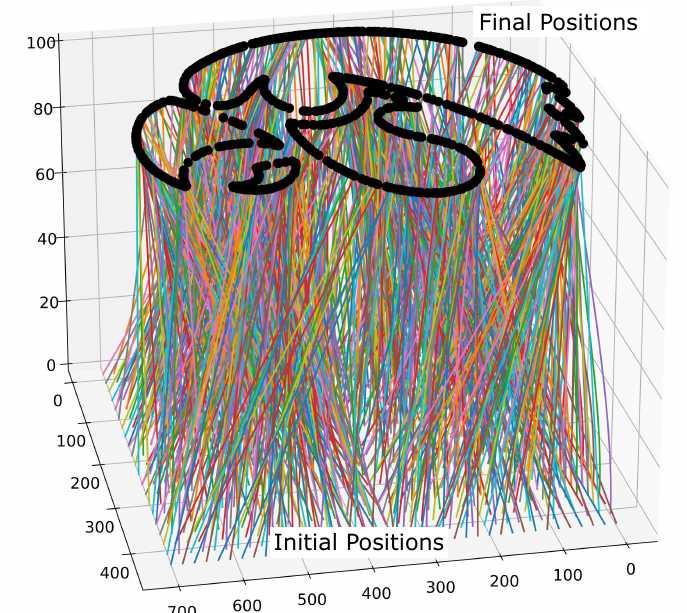
Figure 36. Trajectories for 1000 aerial vehicles with initial and final position and minimum safety distance